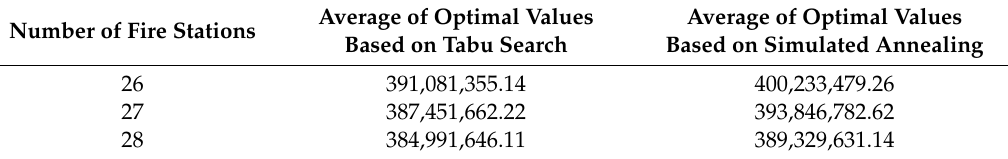
Table 10. Average of optimal values for 10 iterations of the model using both algorithms.